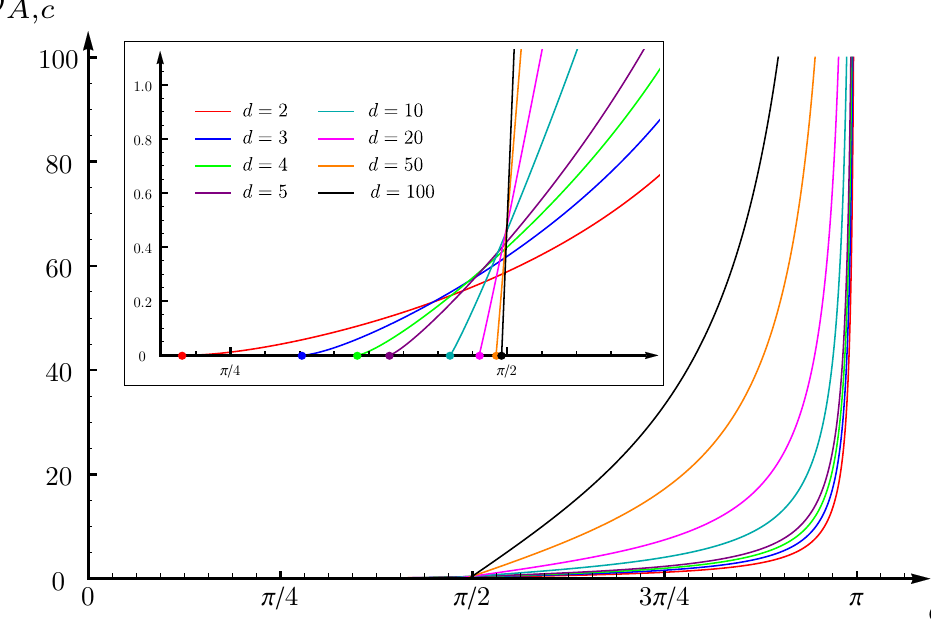
Figure 24 . In(cid:12)nite strip of width ‘ A parallel to the boundary at (cid:12)nite distance d A from it: the ratio (cid:14) A = d A =‘ A corresponding to the critical con(cid:12)gurations in terms of (cid:11) 2 [ (cid:11) c ; (cid:25) ) for some values of d . The curves are obtained by (cid:12)nding the unique positive root of (D.4). For d = 2 and d = 3 the expression of (cid:14) A;c has been written analytically in (5.11) and (D.7) respectively, while for d > 4 the curves have been found by solving (D.4)